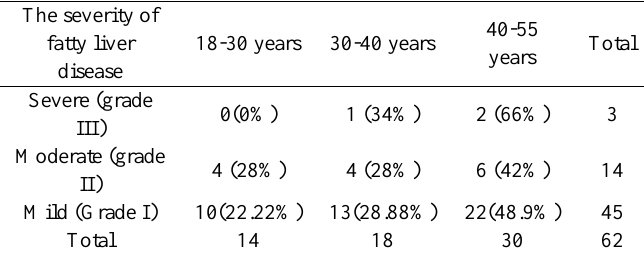
Table 2 : Incidence of NAFLD in relation to age in obese females.